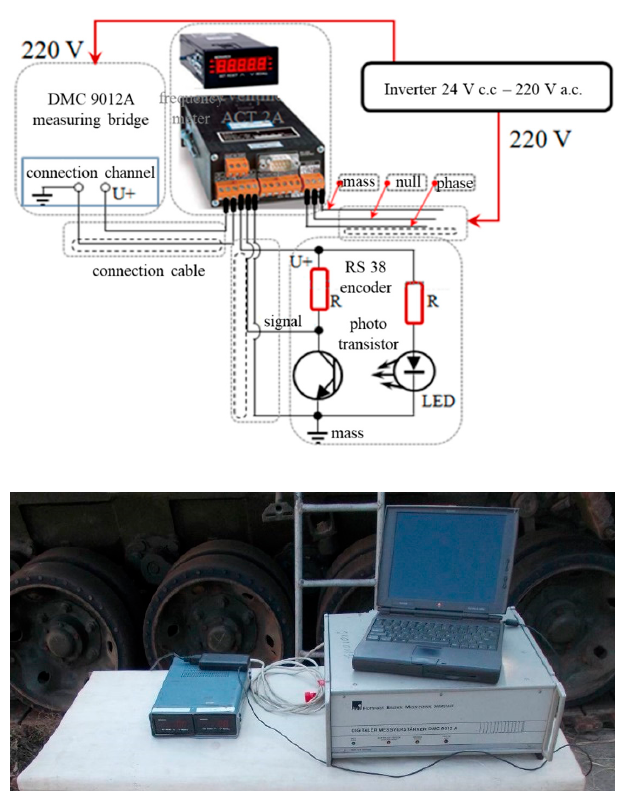
Figure 15. Measuring chain ( δ ): DMC 9012A bridge, frequency meter, laptop.